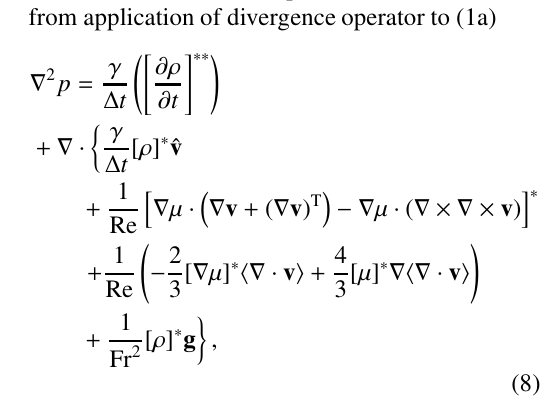
Table 2. Coefficients of IMEX schemes up to order